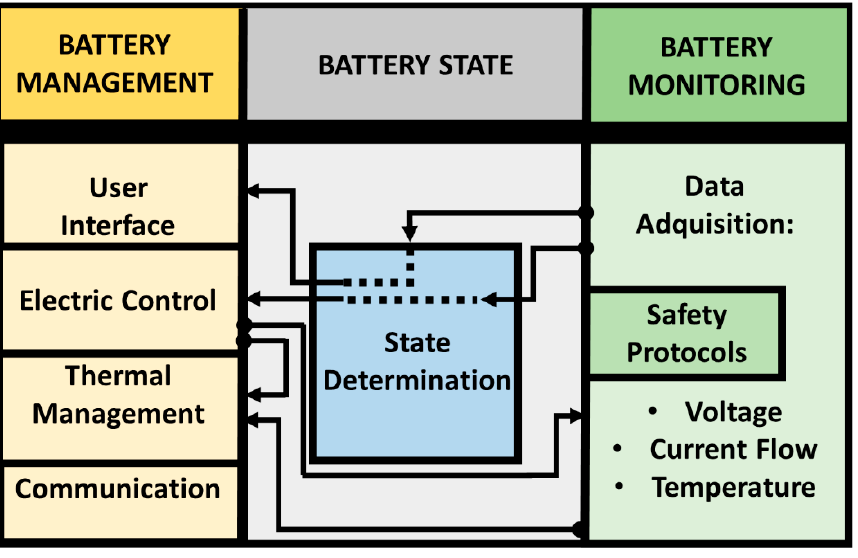
Figure 1. BMS generic architecture.